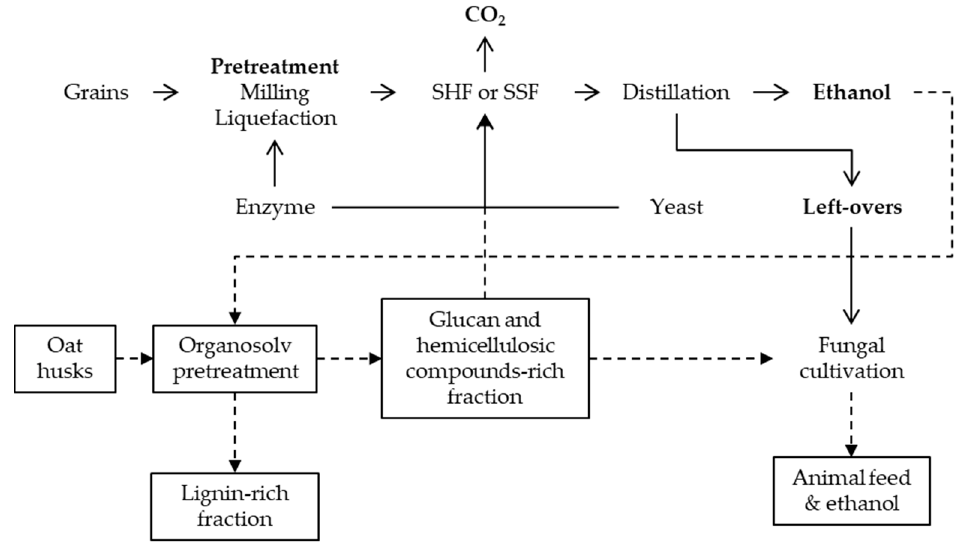
Figure 4. Proposed strategies for the integration of first- and second-generation ethanol. The originating glucan-and hemicellulosic compound-rich fractions are either directed to yeast fermentation (carried out under separate hydrolysis and fermentation (SHF) or simultaneous saccharification and fermentation (SSF)) or to filamentous fungi cultivation. The starch-based first-generation ethanol process is presented as an example; the integration scheme would be similar in first-generation sugar ethanol.